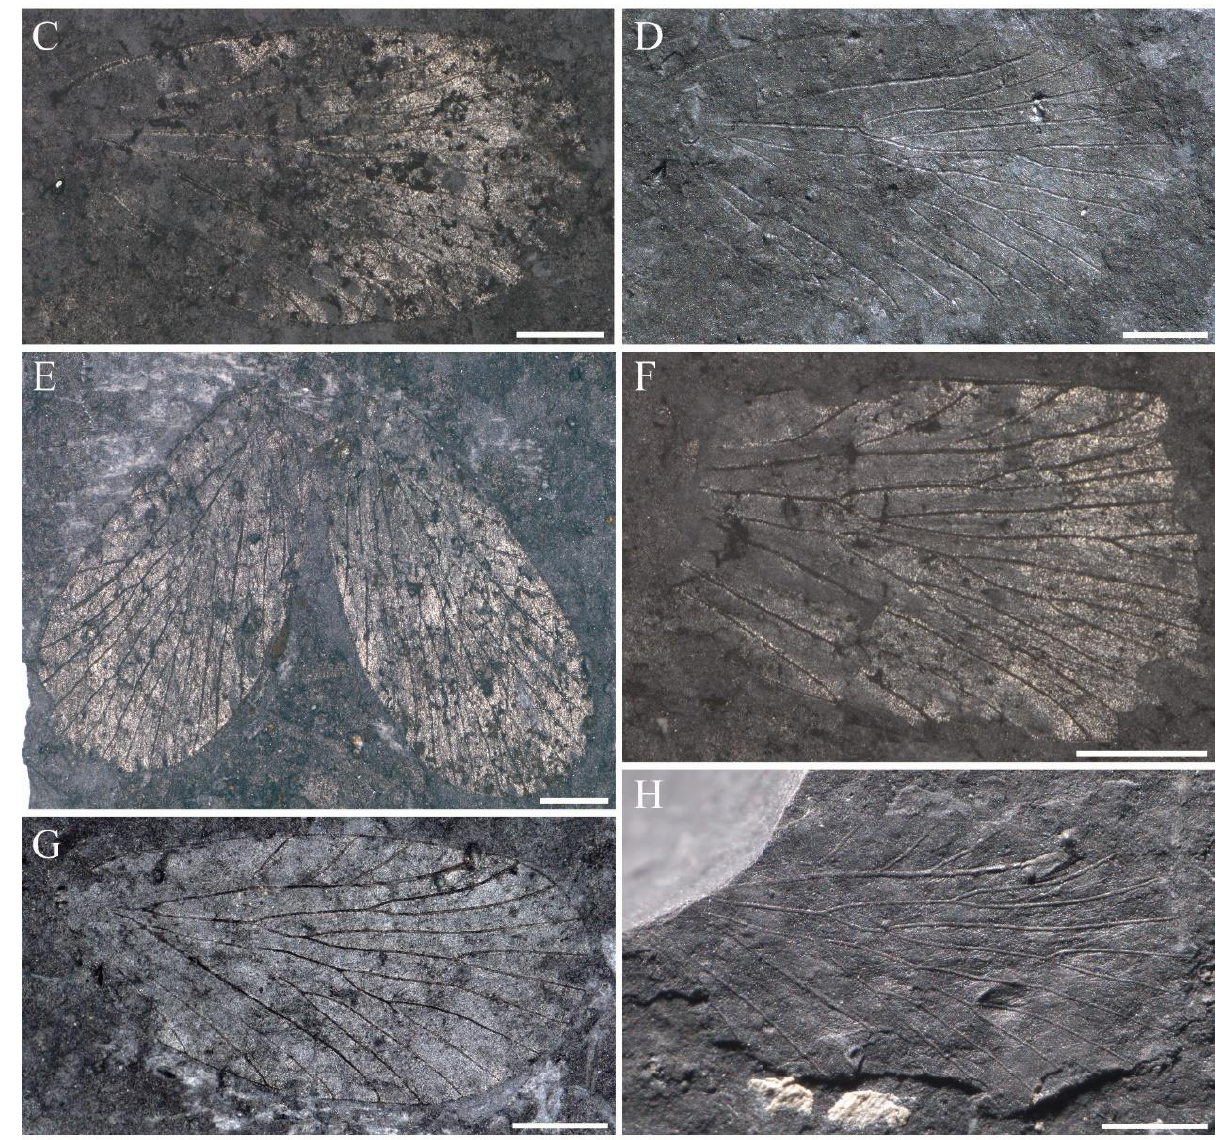
Figure 17. Hind wings of Sinoagetopanorpidae fam. nov. ( A , B ) Photographs of NIGP200930;